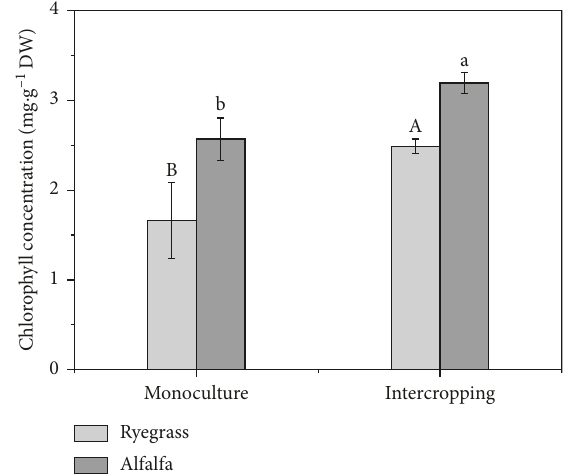
Figure 3: The chlorophyll content in shoots of ryegrass and alfalfa under monoculture and intercropping treatments. Bars are the standard error ( n � 3). Means followed by the same letter are not significantly different at p < 0 .